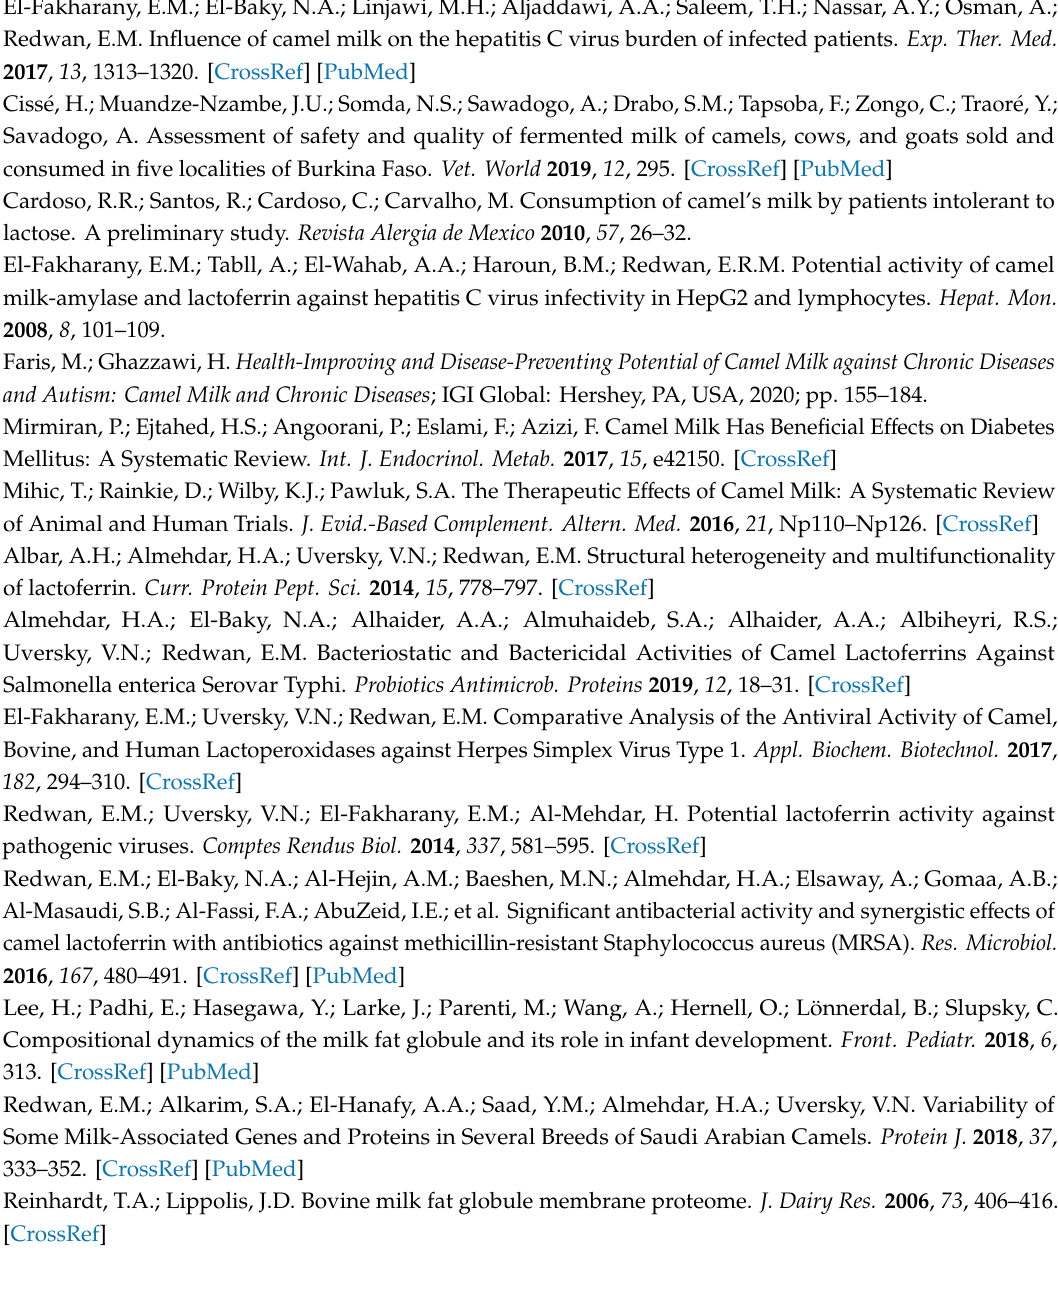
Supplementary Materials: The following are available online, Table S1: Mass spectrometry list of significant di ff erentially abundant proteins, Table S2: Experimental